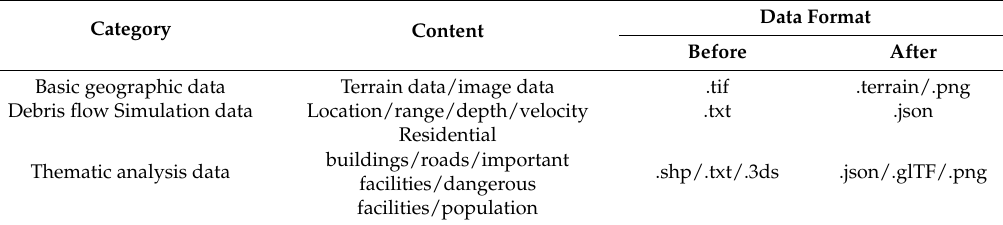
Table 1. Disaster data classification and processing.